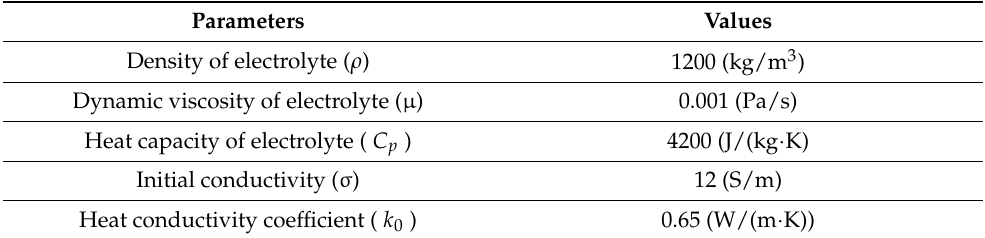
Table 1. Parameters of the simulation